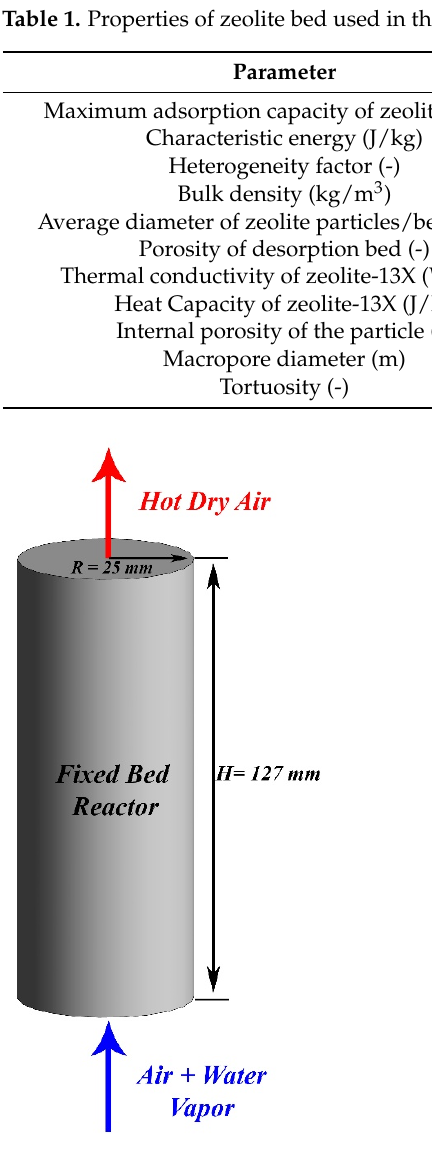
Figure 1. Schematic of the studied reactor. Table 2. Geometrical parameters of the fix bed reactor [22].